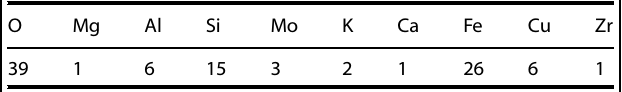
Fig. 4 TEM analyses in the o-GAL. High resolution TEM micrographs ( a + b + c ) highlighting the presence of crystalline phases with inter- reticular distance of 10.4 Å ( σ = 0.6) compatible with smectite group. TEM-EDS spectrum ( d ) corresponding to the crystalline phase (composition in Table 2). Table 2. TEM-EDS composition ( σ < 0.5) in wt.% of the diffracted phase (red rectangles in Fig. 4).